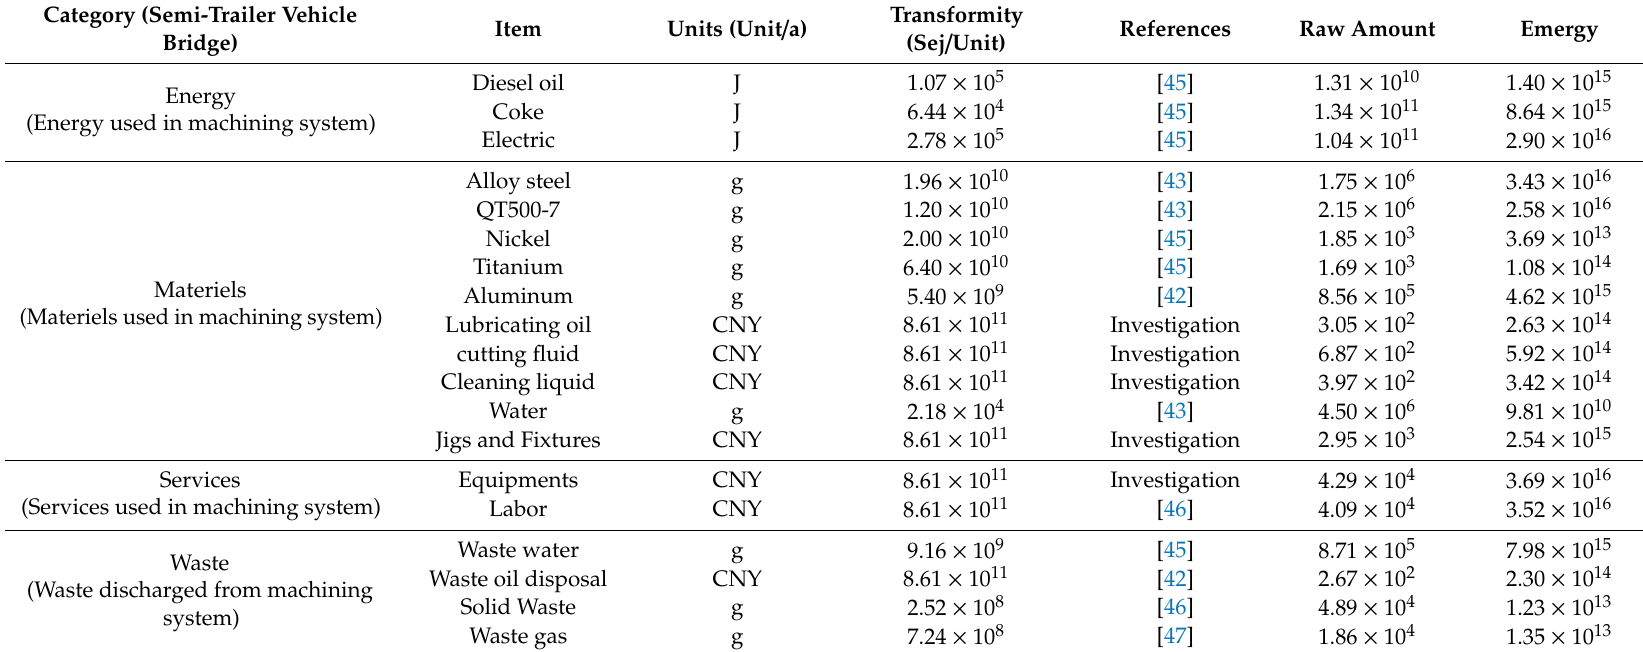
Table 1. Emergy conversion table (unit: /